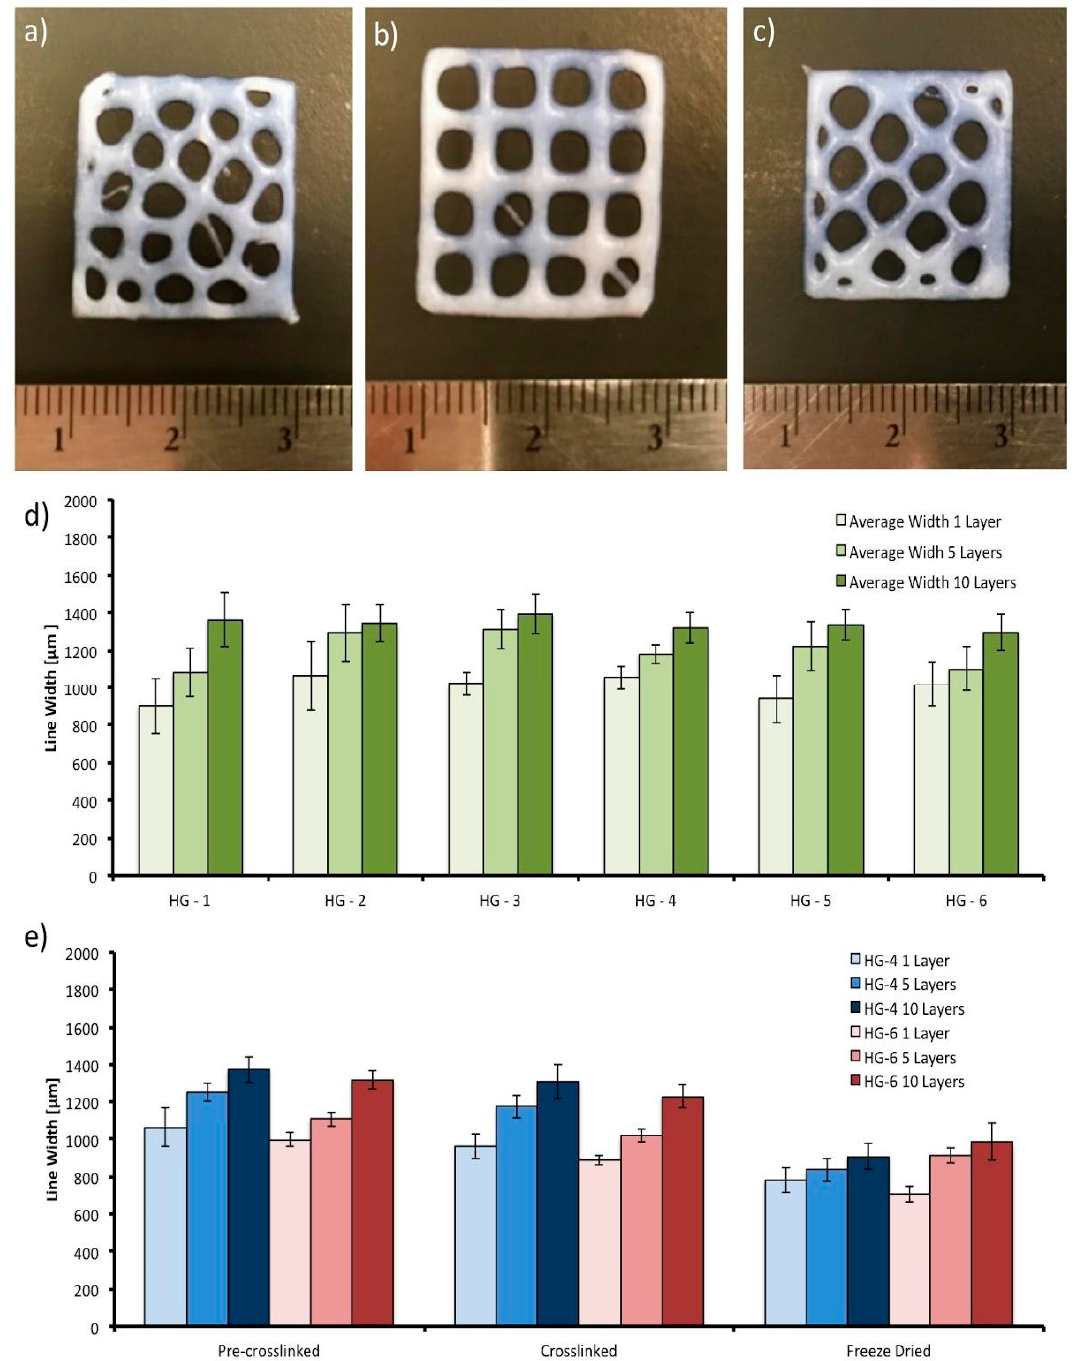
Figure 9. Printed hydrogel designs. From left to right and top to bottom: ( a ) voronoi printed design; ( b ) grid printed design; ( c ) hexagon printed design; ( d ) average line width of the printed hydrogel systems (HG-1 to HG-6) in the grid design with one, five, and ten layers; ( e ) average line width of the hydrogel in the different processes, after printing (pre-crosslinked), after crosslinking, and after freeze drying.